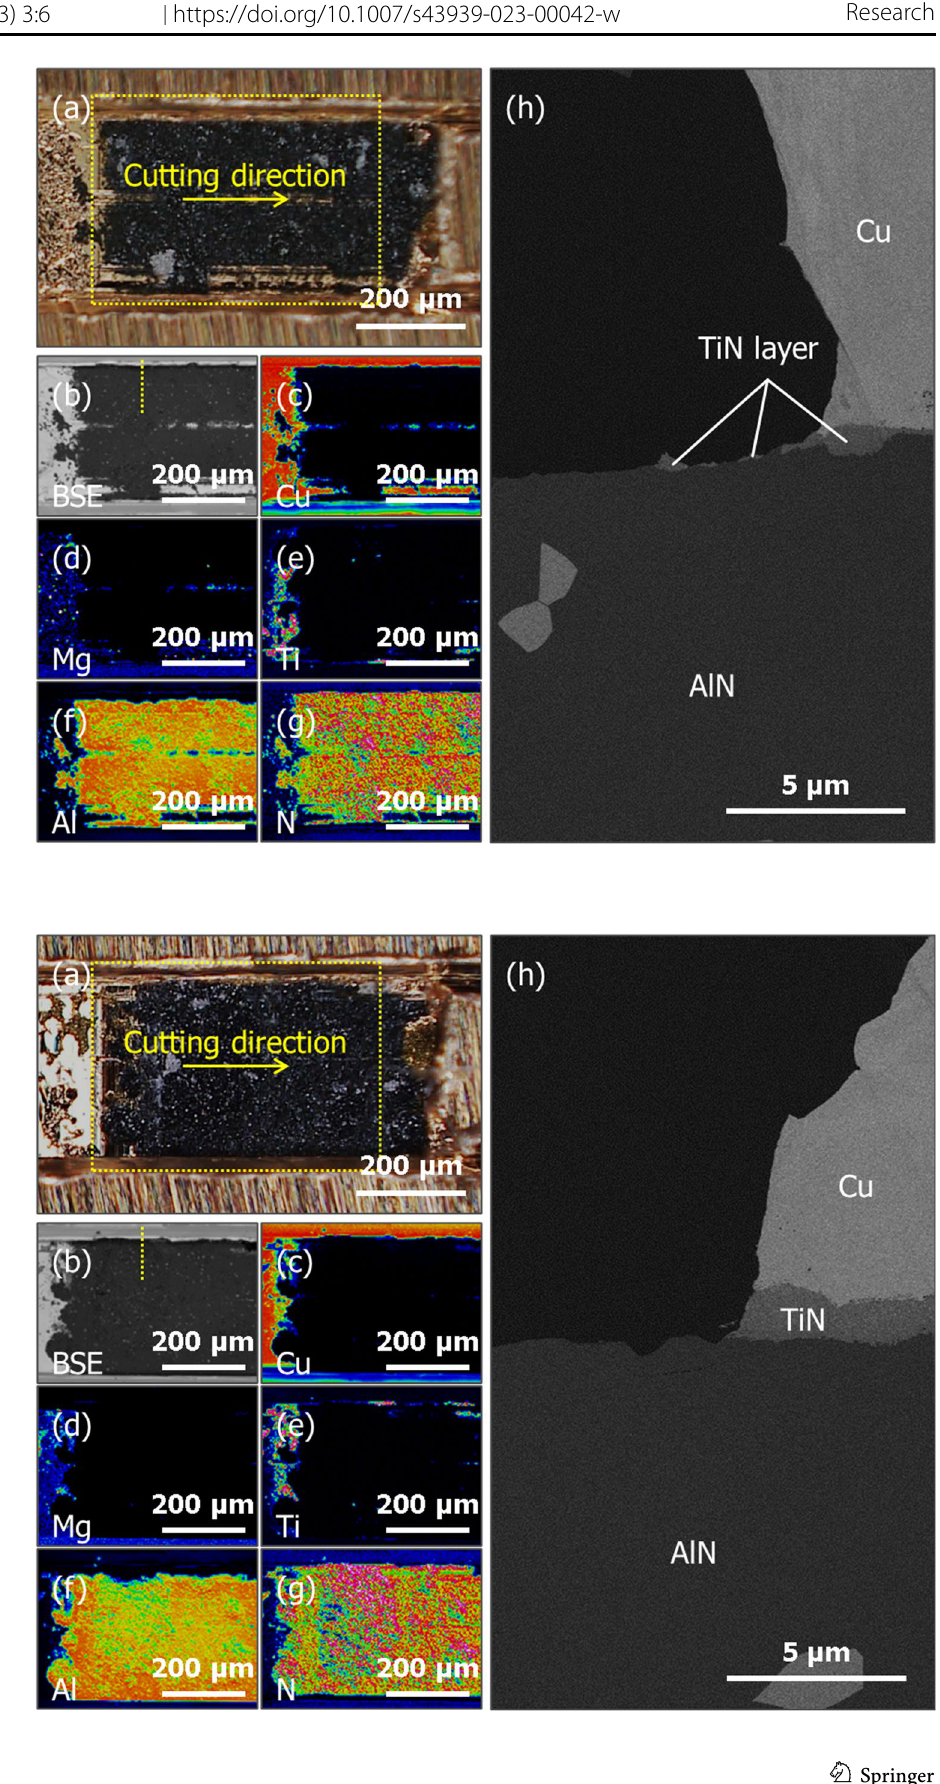
Fig. 8 a Optical image of a specimen bonded at 800 ℃ for 0.5 h after the SAICAS test. w